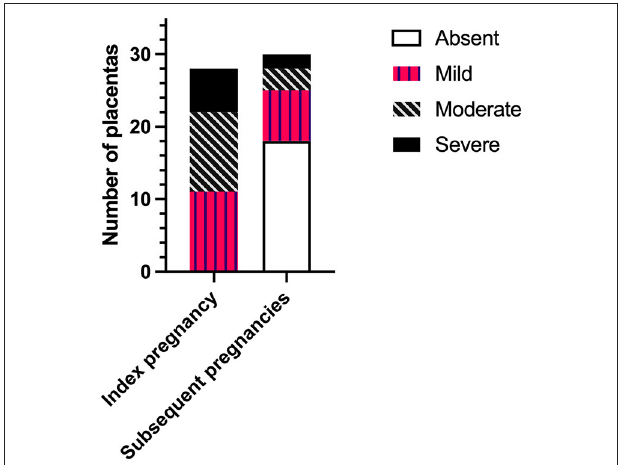
FIGURE 1 | Severity of chronic histiocytic intervillositis (CHI) lesions in placentas from index and subsequent pregnancies according to pathologist’s report. Index CHI refers to a participant’s first pregnancy diagnosed with CHI by placental histopathological examination following poor outcome. Subsequent pregnancies refer to those following diagnosis.